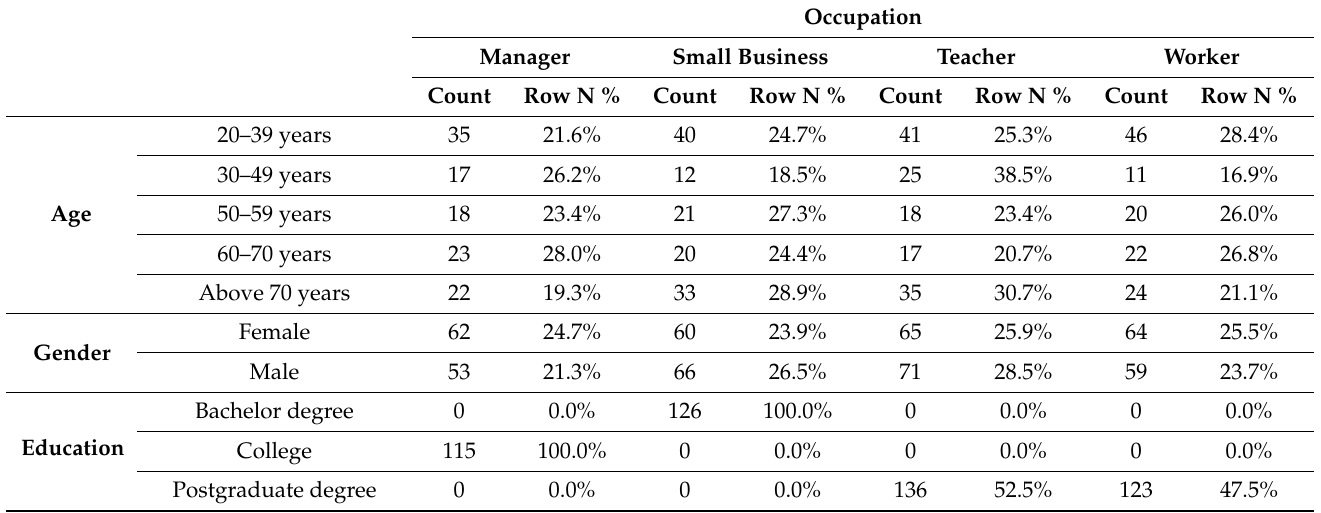
Table 1. Demographic characteristics of survey